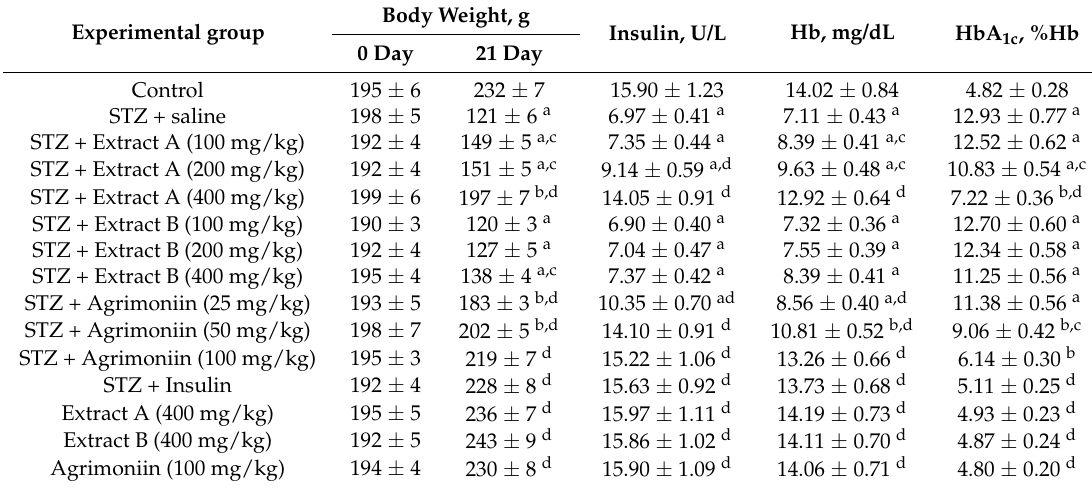
Table 4. Parameters of body weight, insulin, total hemoglobin (Hb) and glycosylated hemoglobin (HbA 1c ) of control and experimental groups, mean ± SD.